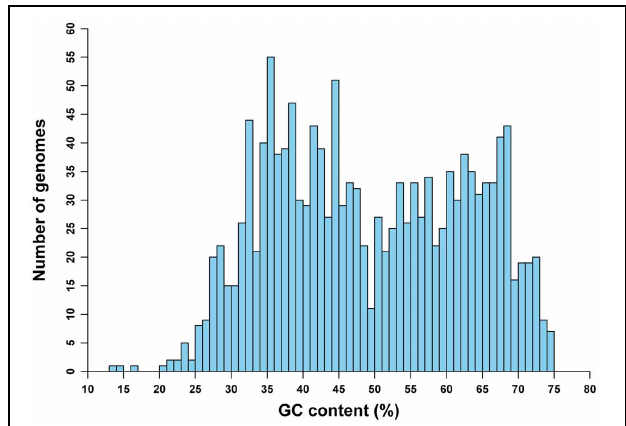
FIGURE 1 | Distribution of 1442 archaeal and bacterial genomes in terms of GC content.